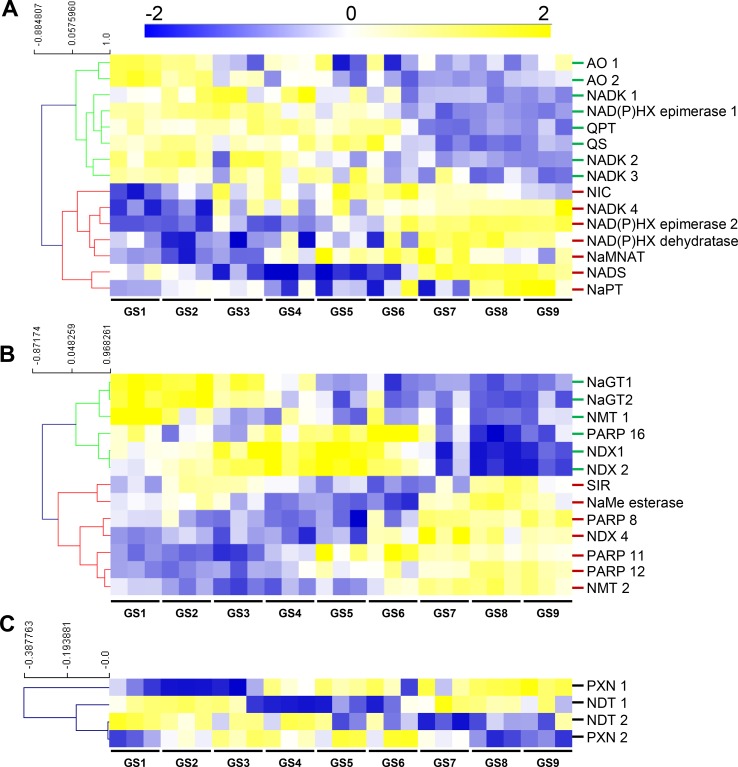
NAD+ synthesis (A), consumption (B), and transport (C) show transcriptional changes during tomato fruit development. Transcript data were normalized (see Materials and Methods) then filtered for statistically significant features (ANOVA with Bonferroni correction, P < 0.01) and subjected to clustering analysis using MeV (http://mev.tm4.org/). Shown are Pearson’s correlations after complete clustering of mRNA profiles. Names on the right refer to as enzymes of NAD+ synthesis (A), consumption (B), or putative transport (C). NIC and NaPT were also found as significantly regulated during fruit growth for protein profiles (Figure S2). AO, aspartate oxidase; GS, growth stage; NADK, NAD kinase; NAD(P)HX, NAD(P)H hydrate; NaMNAT, NaMN adenylyltransferase; NADS, NAD synthetase; NaGT, nicotinate N-glucosyltransferase; NaPT, nicotinate phosphoribosyltransferase; NaMe, nicotinate methyl; NMT, nicotinate methyltransferase; NDT, nicotinamide adenine transporter; NDX, nudix; NIC, nicotinamidase; PARP, poly-ADP-ribose polymerase; PXN, peroxisomal NAD carrier; QPT, quinolinate phosphoribosyltransferase; QS, quinolinate synthase; SIR, sirtuin.